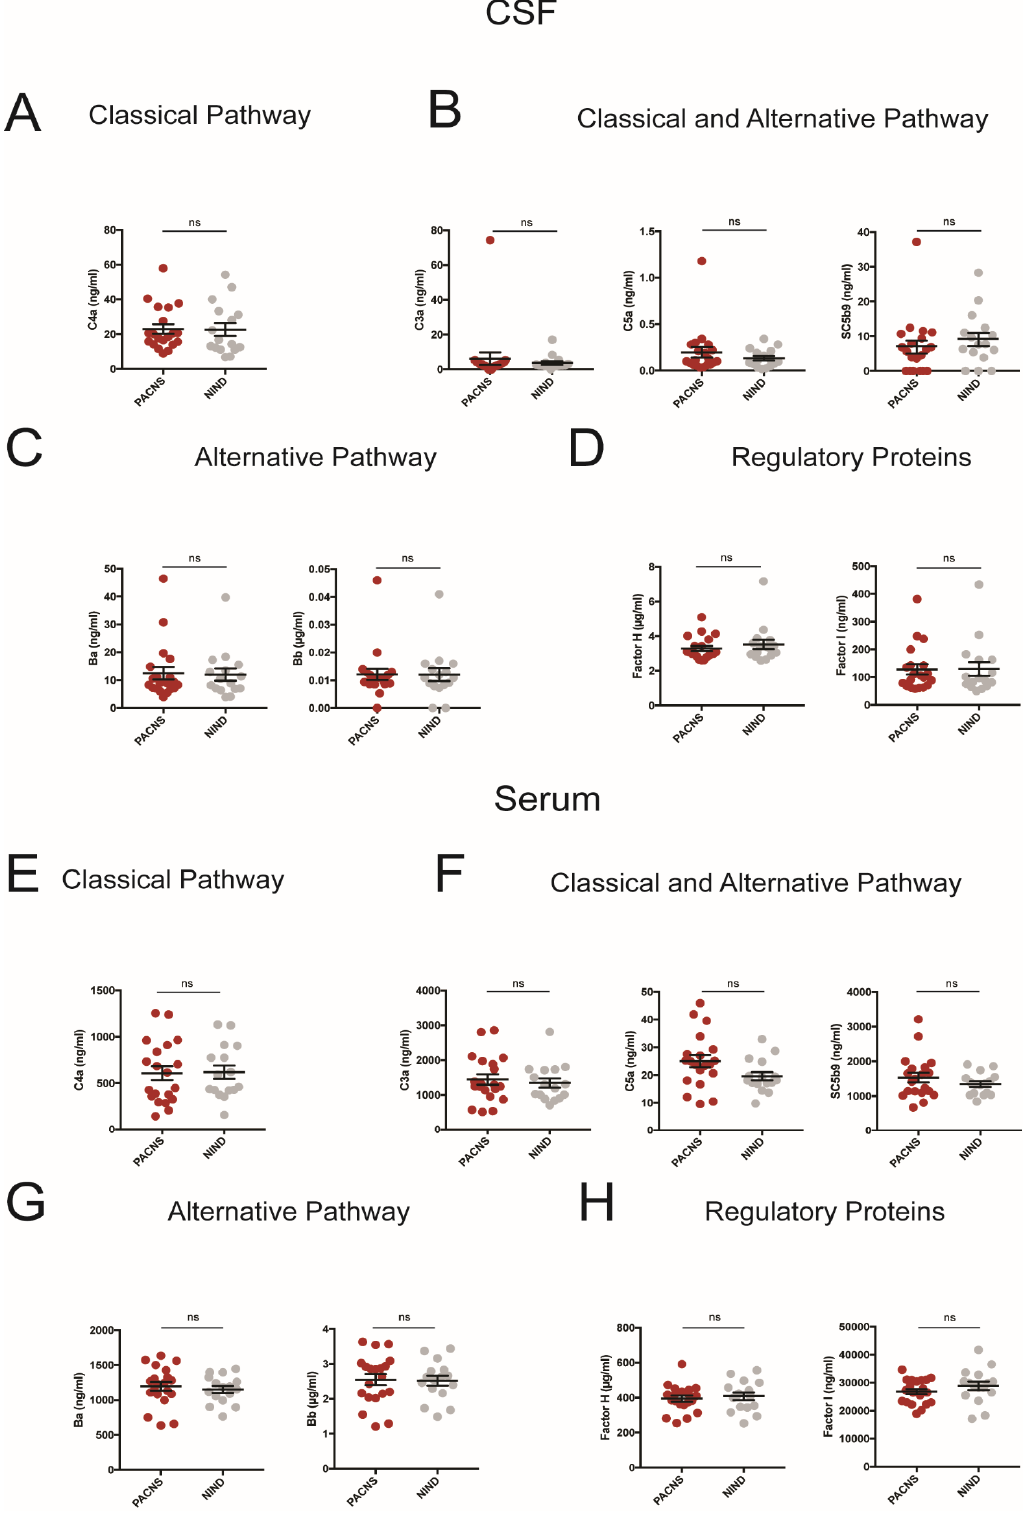
Figure 1. CSF ( A – D ) and Serum ( E – H ) concentrations of complement proteins representative for distinct complement acti- vation pathways and regulatory pathways ( A , E : classical pathway; B , F : classical and alternative pathway; C , G : alternative pathway; D , H : regulatory proteins). PACNS patients compared to patients with non-inflammatory neurologic disease (NIND). Each dot represents an individual